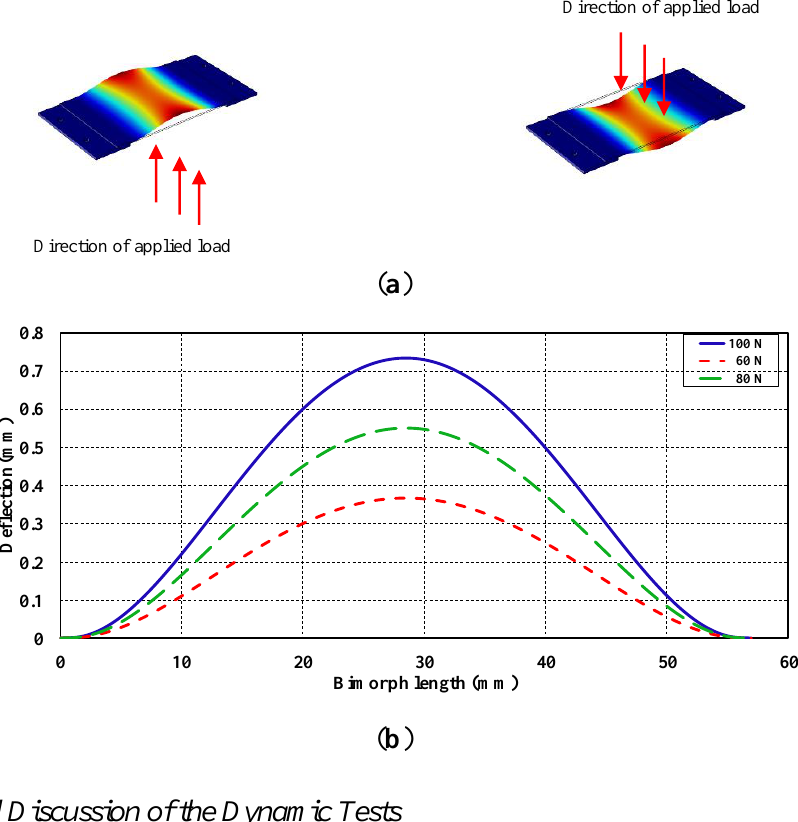
Figure 11. Performance of the piezoelectric bimorph, ( a ) Bimorph deflection when load applied at both faces; ( b ) Piezoelctric bimorph’s deflection at different applied loads, simulation performed using Comsol